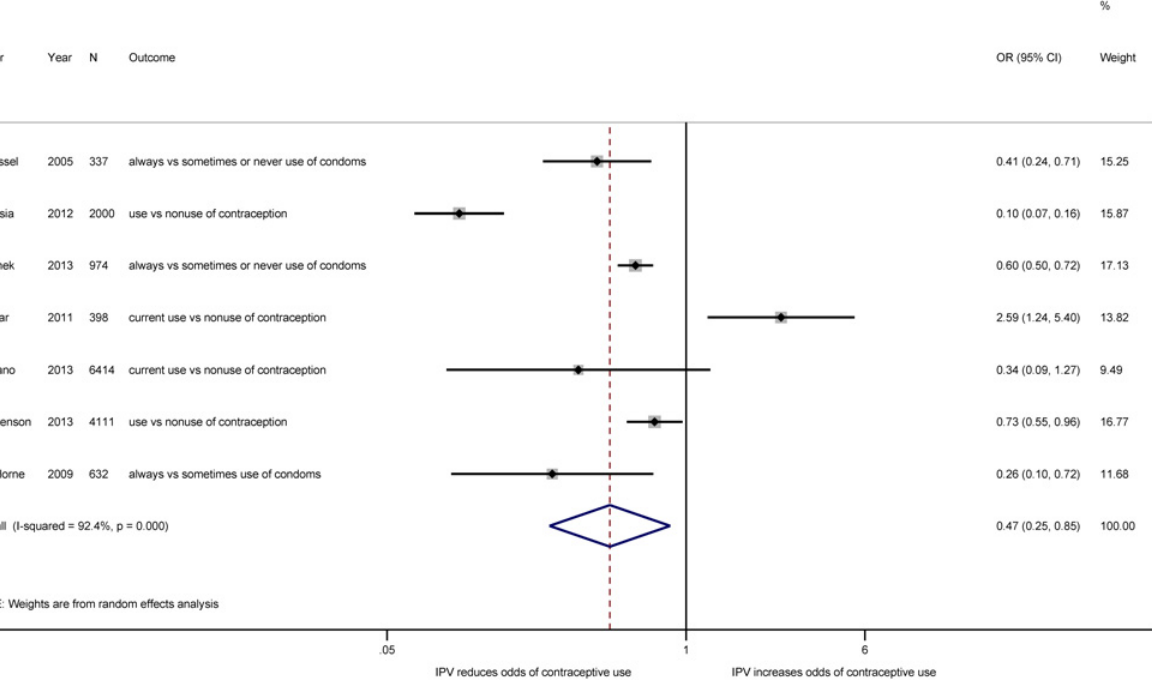
Fig 2. Meta-analysis of the association between IPV and contraceptive use. Estimated effect measures from the Fantasia, Kacanek, and Van Horne studies have been inverted to present estimates of contraceptive use rather than non-use.